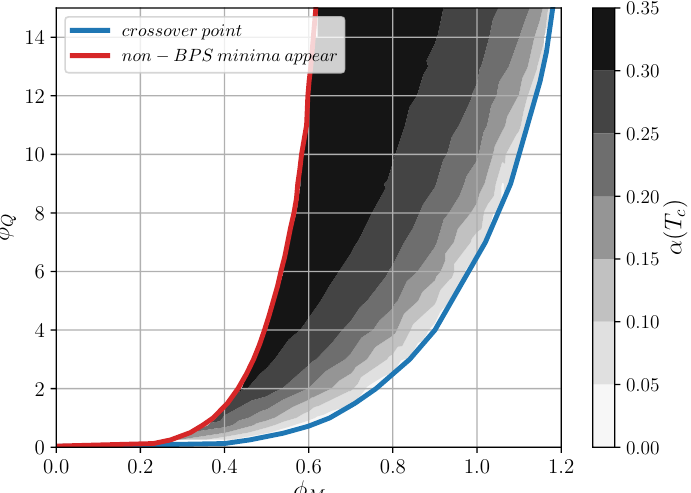
Figure 6 . Scan of the transition strength parameter α at the critical temperature for different values of the scalar potential